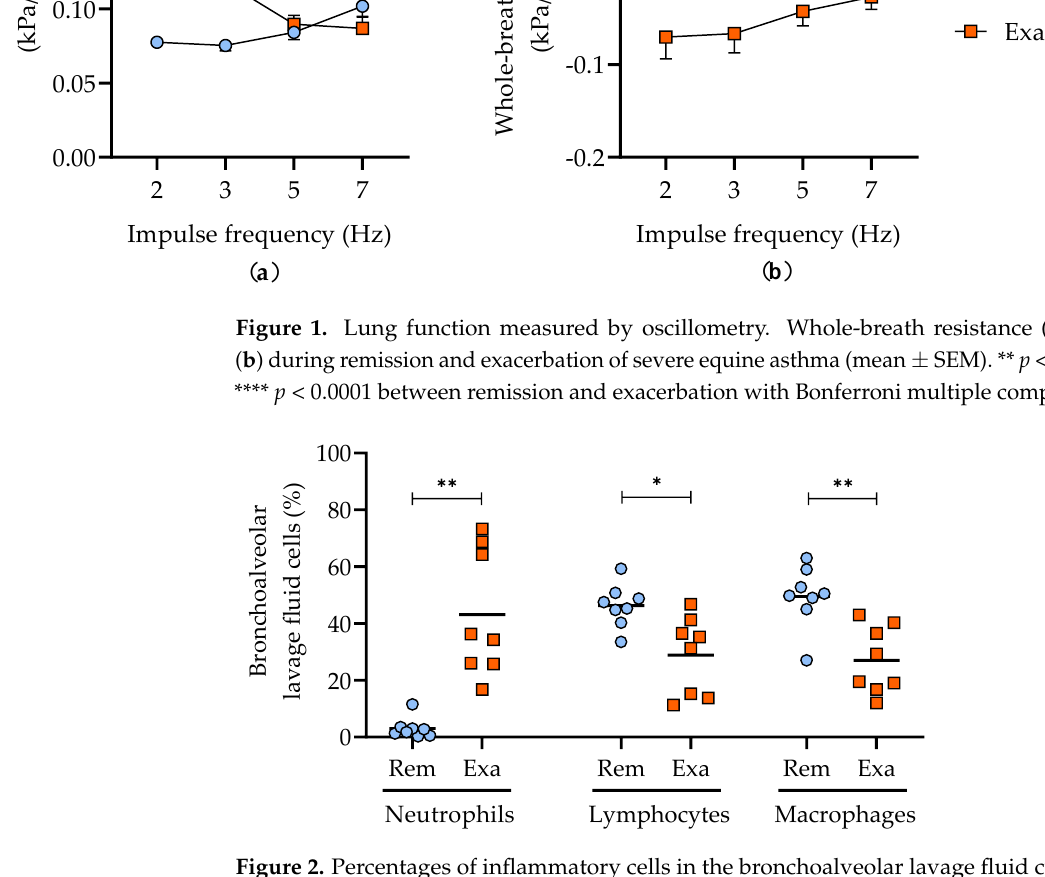
Figure 2. Percentages of inflammatory cells in the bronchoalveolar lavage fluid cytology of horses during remission (Rem) and exacerbation (Exa) of severe equine asthma (dot plot with mean). * p < 0.05, ** p < 0.01 with paired T-tests or Wilcoxon tests.